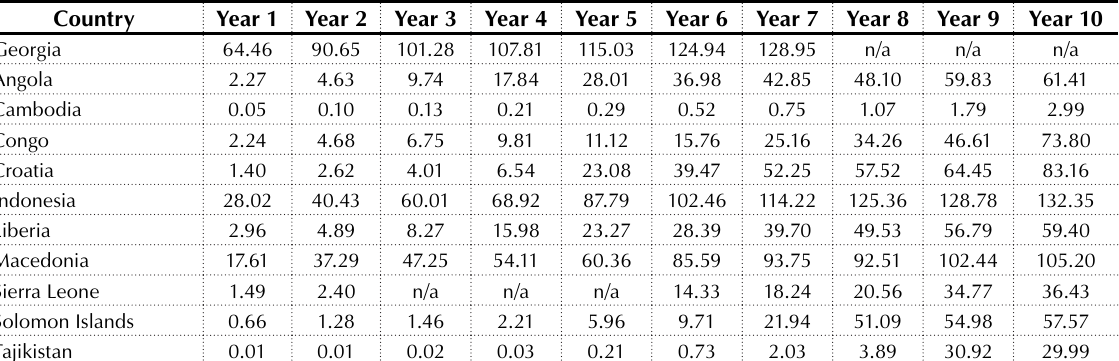
Source: The World Bank Group database.